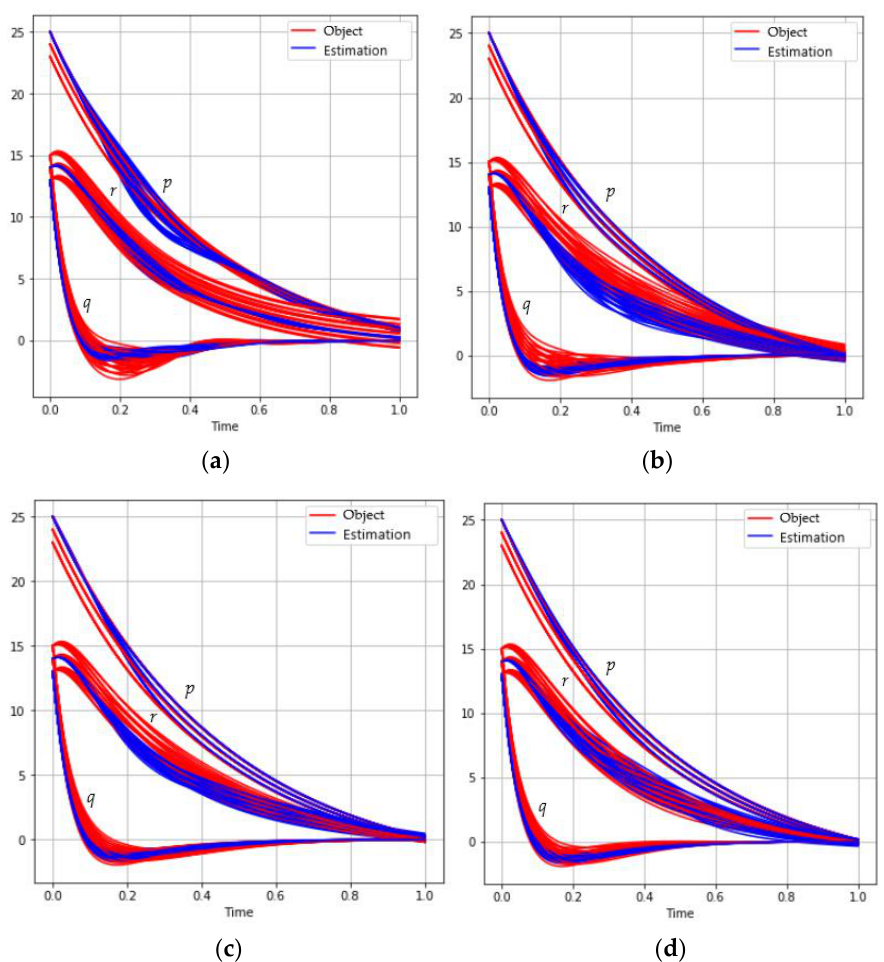
Figure 2. The behavior of the satellite coordinates p , q , r (red) and estimations (blue) for different mini-batch sizes: ( a ) d = 1; ( b ) d = 10; ( c ) d = 20; ( d ) d =